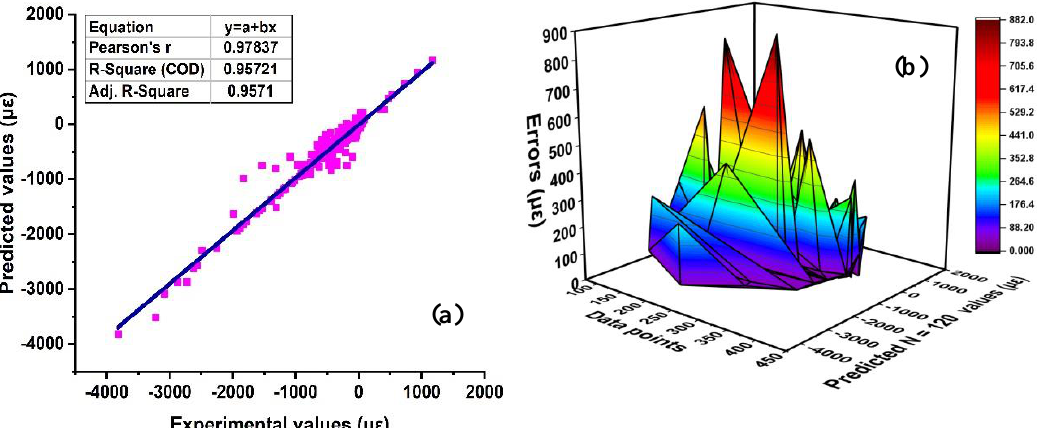
Figure 5. ( a ) SVM with AdaBoost; ( b ) errors of ensemble model of SVM with AdaBoost. Table 3. SVM model statistical measures to depict its significance. Statistical Measures SVM Model